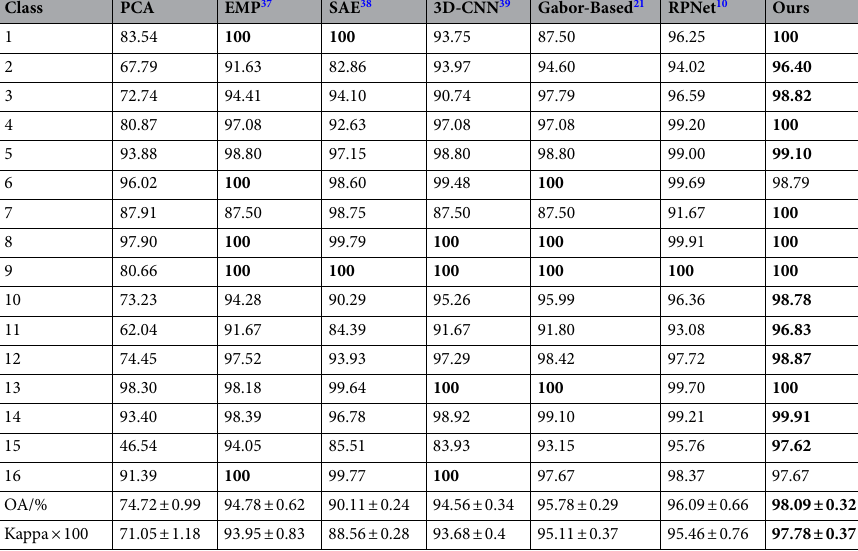
Table 4. Classification accuracy of Indian Pines Dataset.